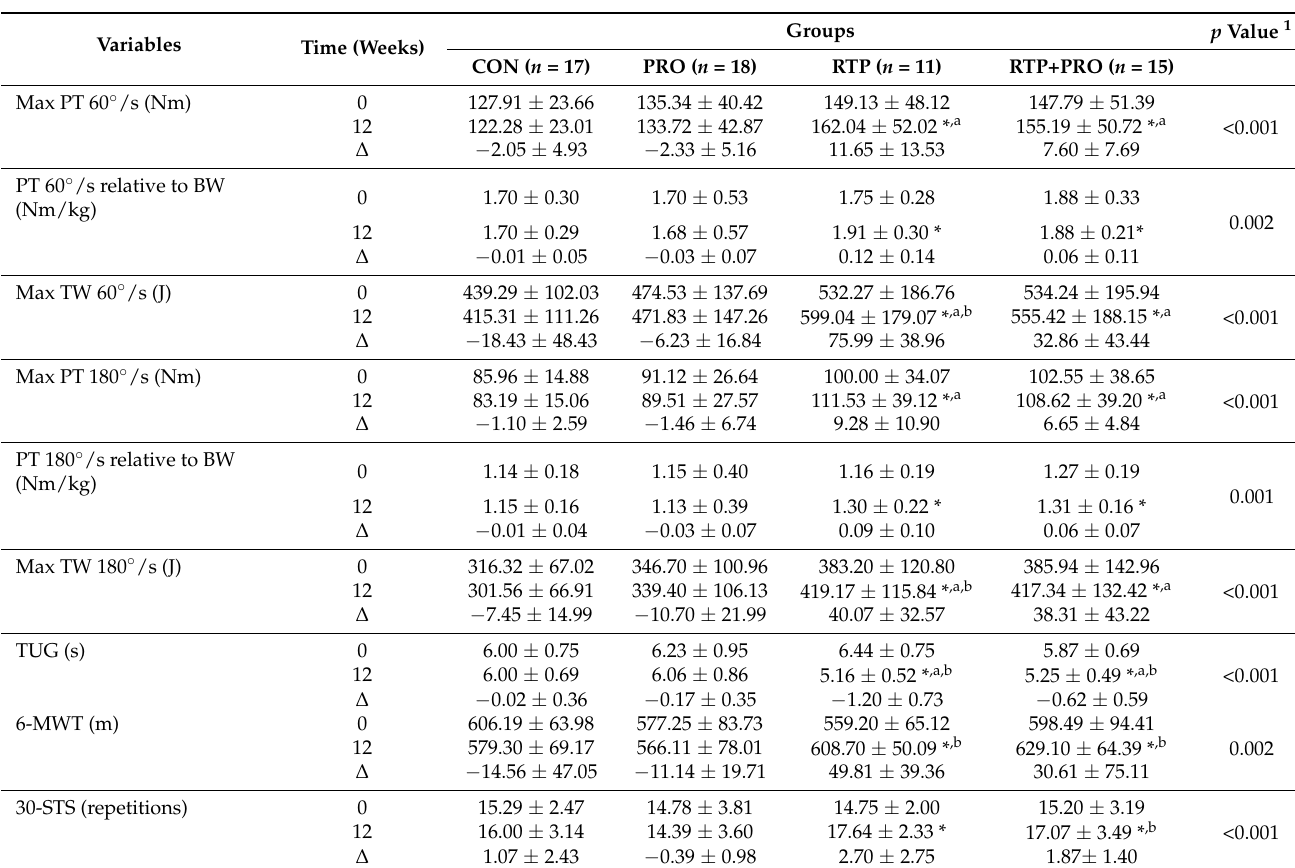
Table 3. Effect of resistance training and protein supplementation, isolated or combined, on muscle strength (MS) and physical function (PF) parameters and adherence to the resistance training program of individuals in the mid- to-late postoperative period after RYGB.